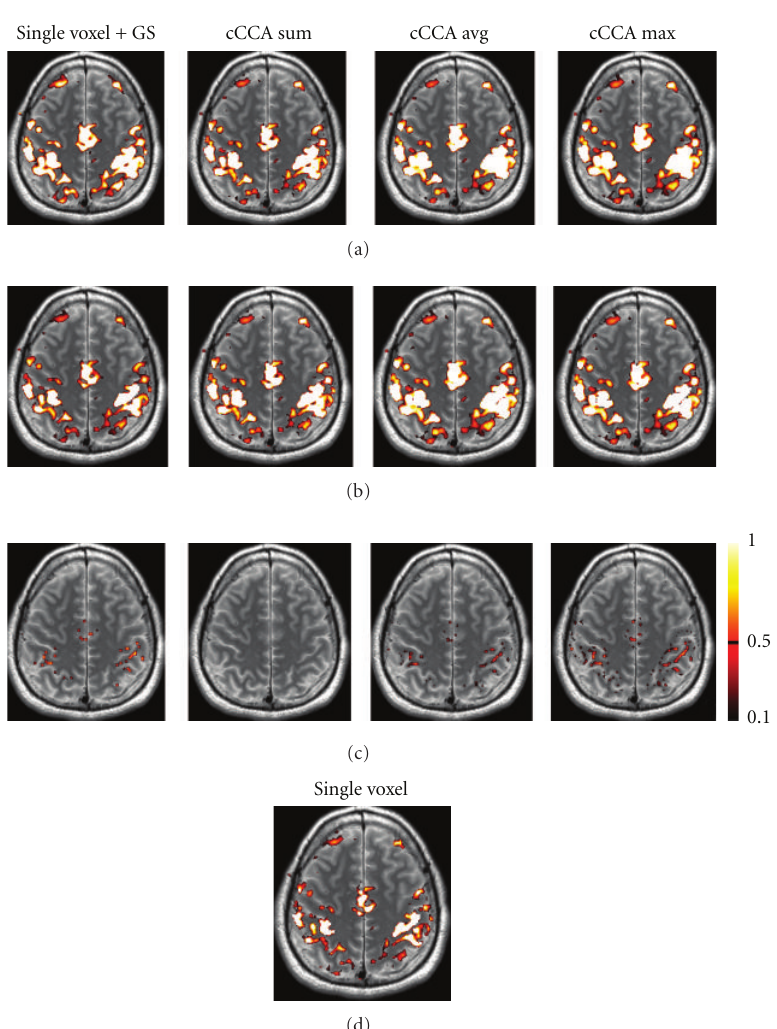
Figure 6: Motor activation maps for contrast “motor” minus “fixation” using di ff erent data analysis methods (single voxel with Gaussian smoothing (GS), CCA with the sum constraint (cCCA sum), CCA with the average constraint (cCCA avg), CCA with the maximum constraint (cCCA max)). In (a), original activations maps are shown at FWE < 0.05. In (b), activation maps corrected for the smoothing artifact are shown. Corrections are done for P > 0 . 5. In (c), voxels a ff ected by the smoothing artifact are shown. The color scale on the right refers to the magnitude of the smoothing artifact in (c). In (d) we show for comparison the activation map for single voxel analysis without Gaussian